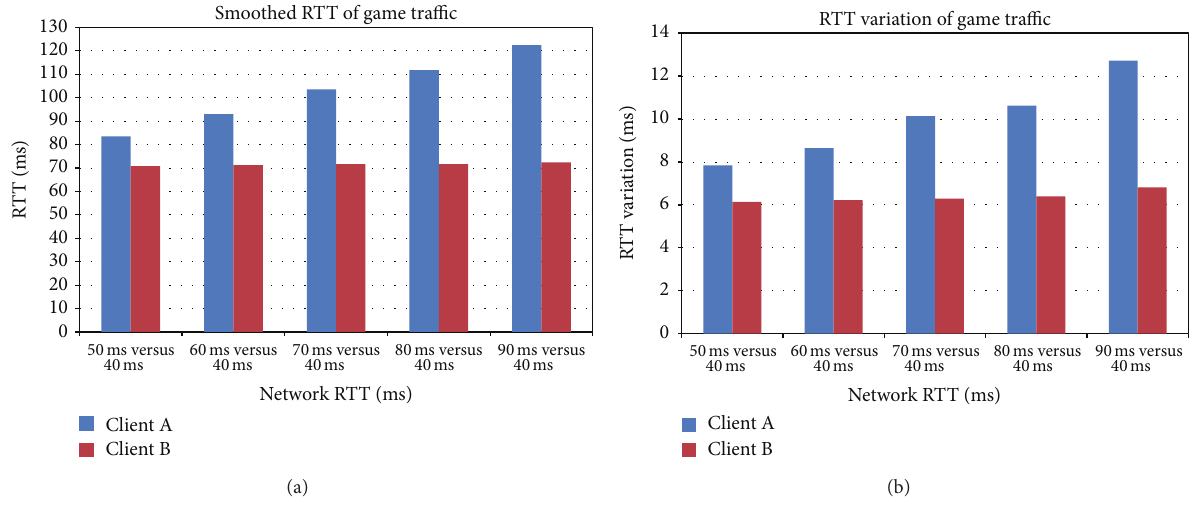
Figure 16: Latency of MMORPG flows from client A and client B (a) Smoothed RTT and (b) RTT variation.